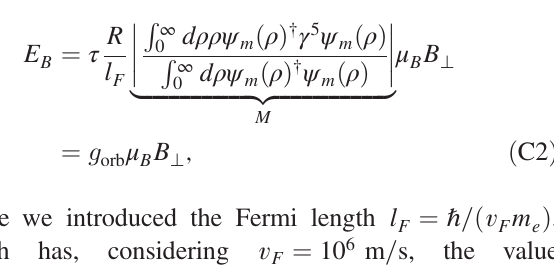
Fig. 8 for fields B ⊥ ¼ 0 , 2.5 T. In the legend, the states are